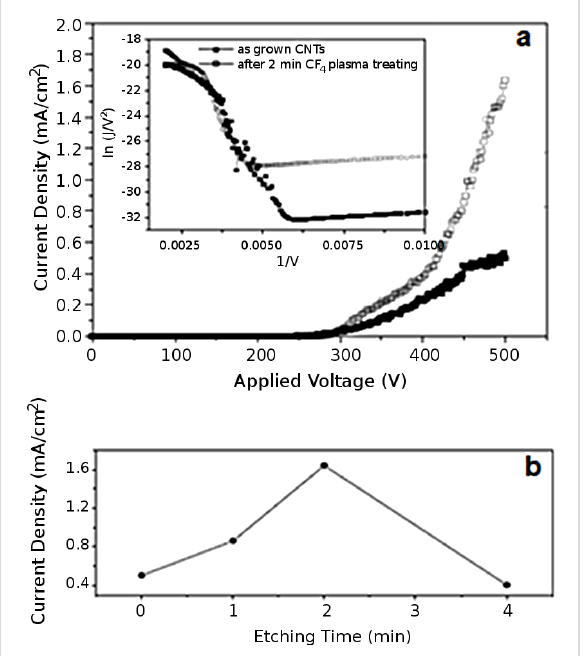
Figure 9: Effect of oxygen plasma functionalization on the VA-CNTs. (1) Optical microscopy images of the contact angle between deionized water (magnification X200) and (2) FEG-SEM images presenting the morphological structure of VA-CNTs. Figure a.1 and b.1 shows the as-grown VA-CNT. Details of oxygen plasma etching: (Figure a.2 and b.2) 1 min., (Figure a.3 and b.3) 2 min. and (Figure a.4 and b.4) 5 min. Adapted with permission from [91]. Copyright 2012